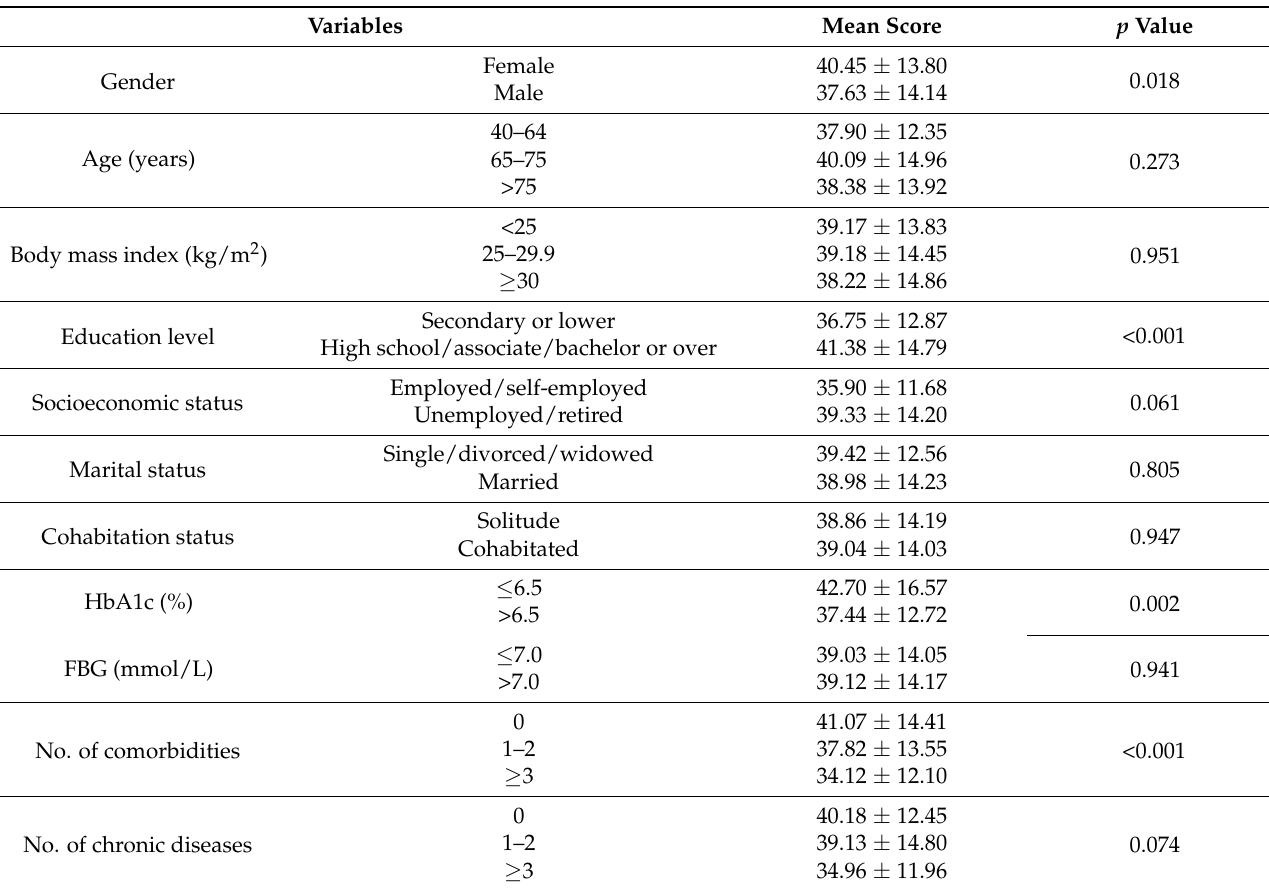
Table 3. Univariate analysis of the Summary of Diabetes Self-Care Activities (SDSCA) measure stratified by